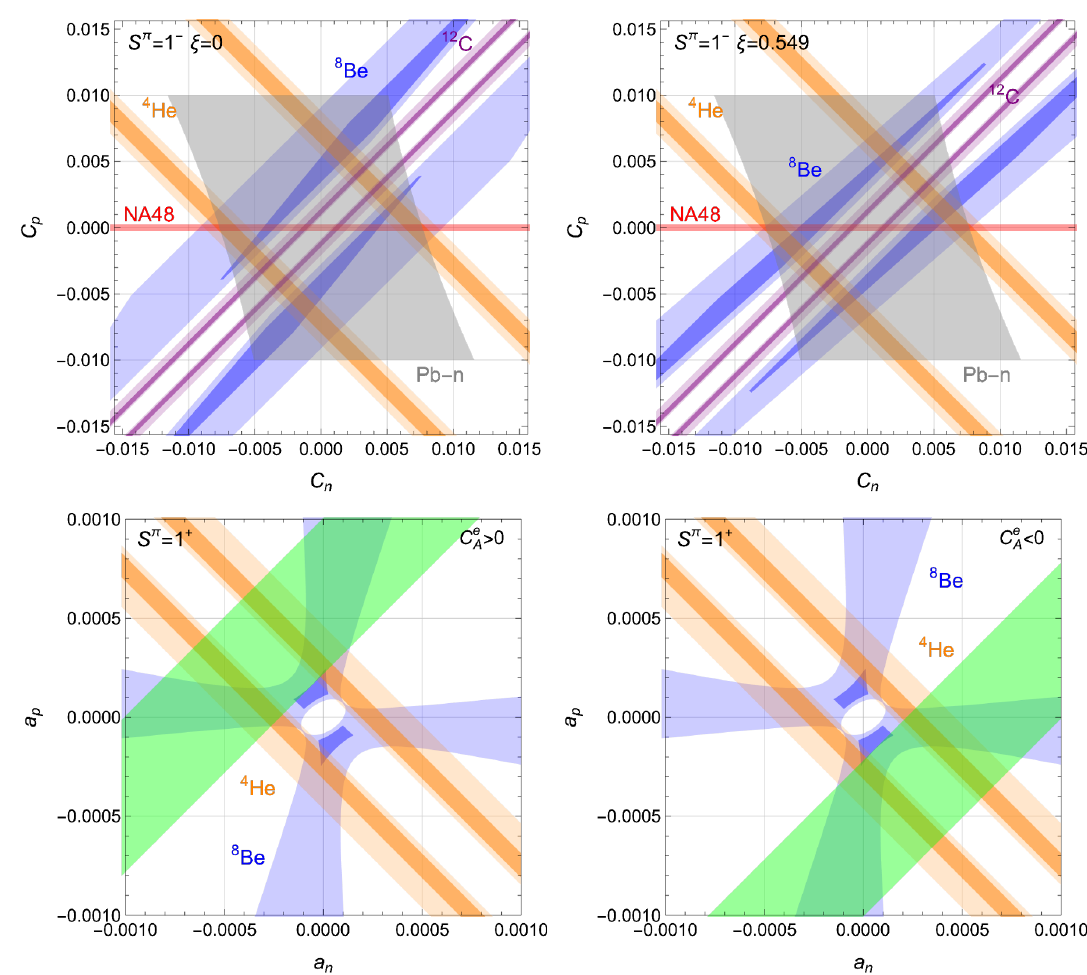
Figure 11 . Upper panels: Regions of the C n,p effective nuclear couplings of a pure vector state where the 8 Be (blue), 4 He (orange) and 12 C (purple) anomalous ATOMKI transition can be explained at 1 σ or 2 σ . Inside the red and the gray region, respectively, the NA48 and the 208 Pb-n scattering bound are satisfied. In the left and right panel we assume ξ = 0 and ξ = 0 . 549 respectively, see appendix B.1 for details. Lower panels: Regions of the a effective nuclear couplings of a pure n,p axial vector state where the 8 Be (blue) and 4 He (orange) anomalous ATOMKI transition can be explained at 1 σ or 2 σ . In the green region the KTeV anomaly in π → e + e − decay can be satisfied, by assuming a positive (left panel) and negative (right panel) value for the C e axial coupling of the A X boson to electrons that can explain the anomalous ( g − 2) e . In all figures both the 8 Be(18.15) and the 8 Be(17.64) transitions are considered, see main text for more